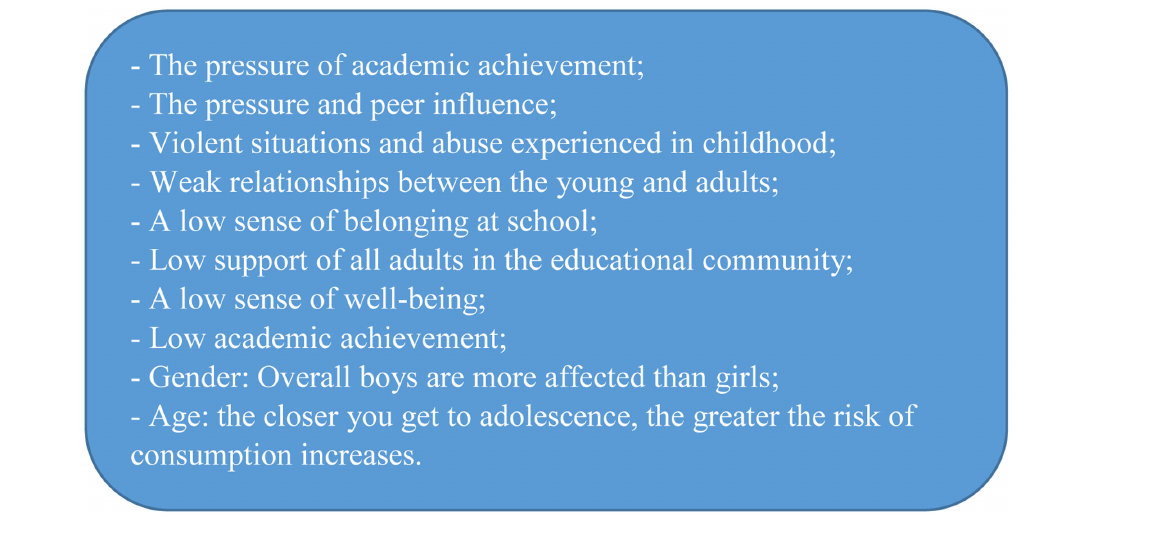
FIGURE 2 | The risks factors associated with addictive